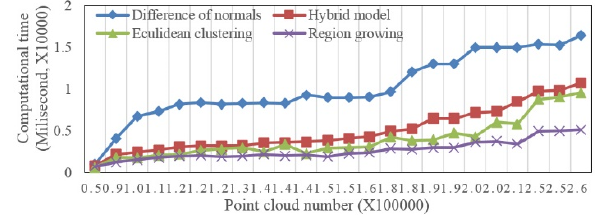
Figure 9. Time consumption comparison using four segmentation methods to segment 25